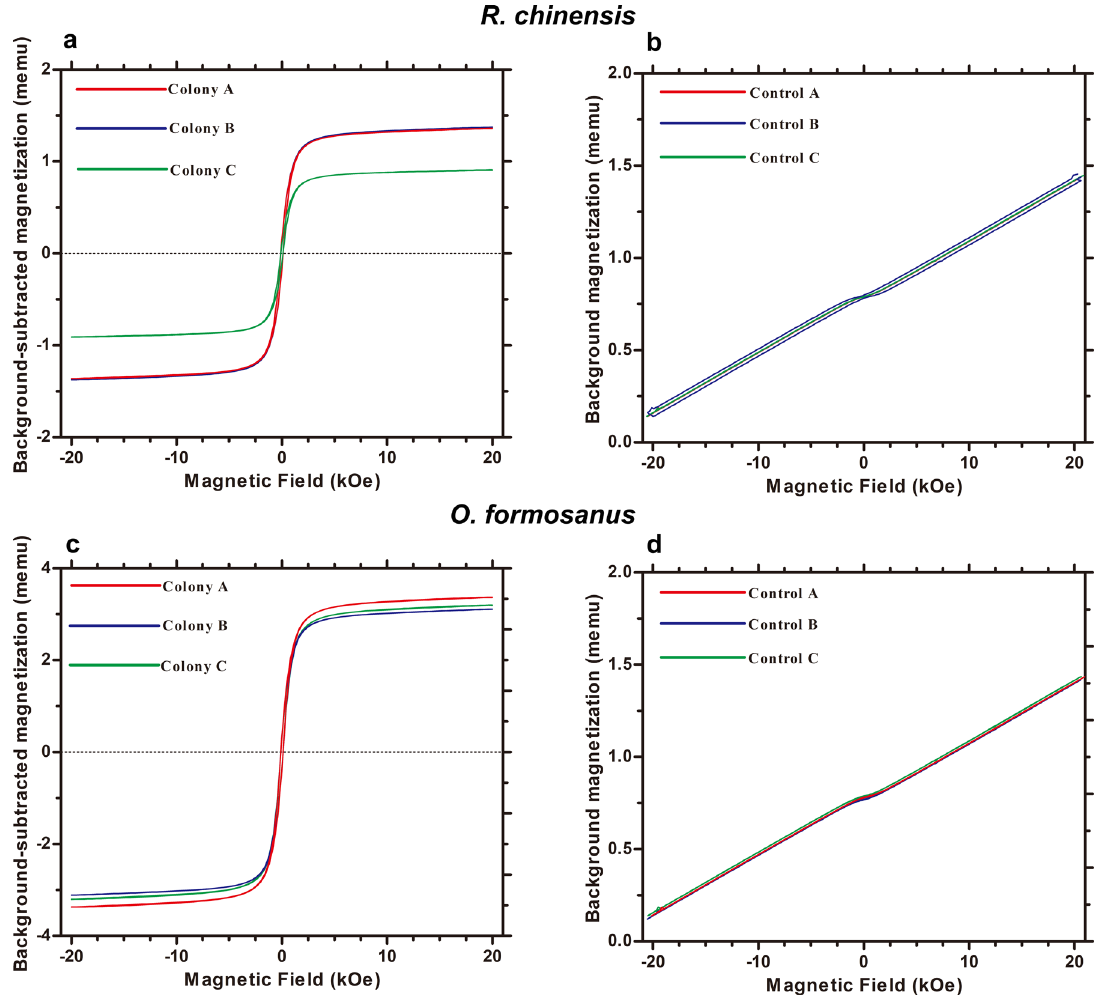
Fig. 4 The measurement of magnetic particles using VSM for the workers of two termite species. a , b Hysteresis curves of worker R. chinensis ( a ) and empty cellulose capsules ( b ). c , d Hysteresis curves of worker O. formosanus ( c ) and empty cellulose capsules ( d